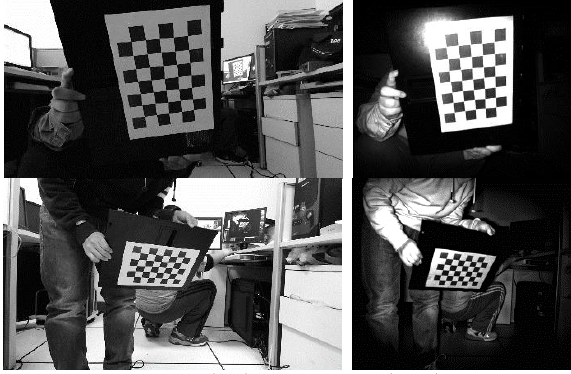
Figure 5. Color image (left) and IR image (right) for calibration with chessboard 5x7x0.03 pattern